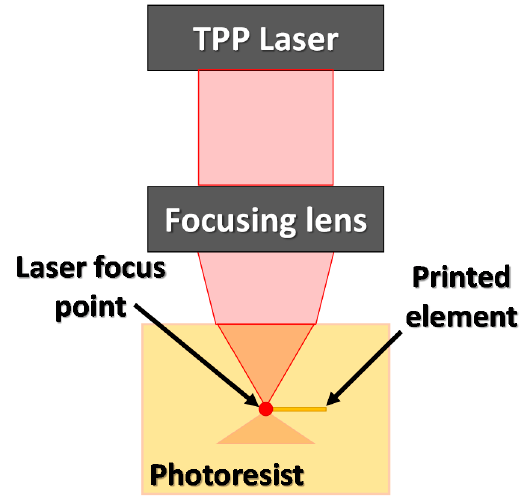
Figure 15. Two-photon polymerization (TPP) for direct writing in the photoresist scheme.